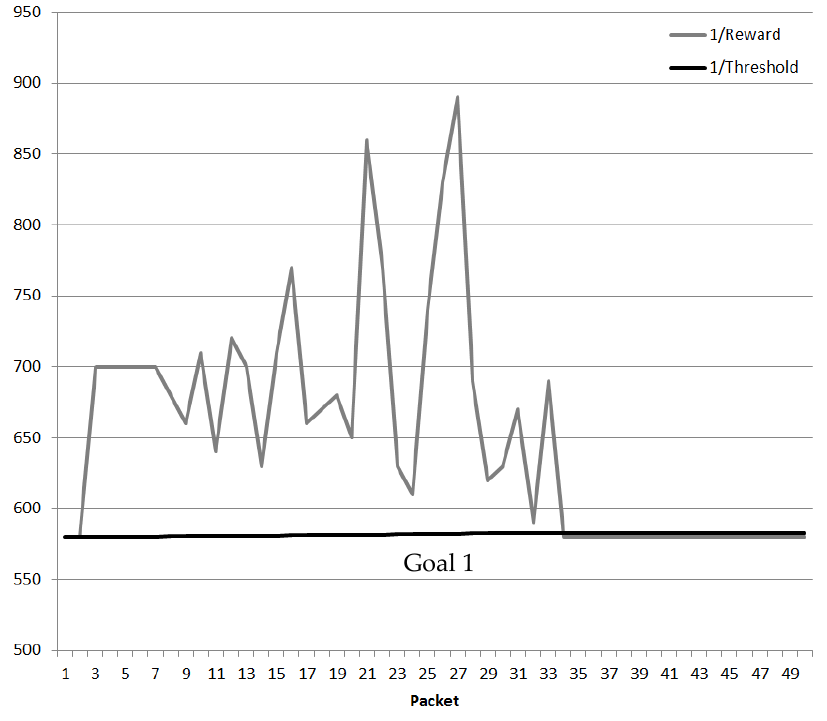
Figure 11. QoS DL Cluster validation (5 × 5 Nodes).